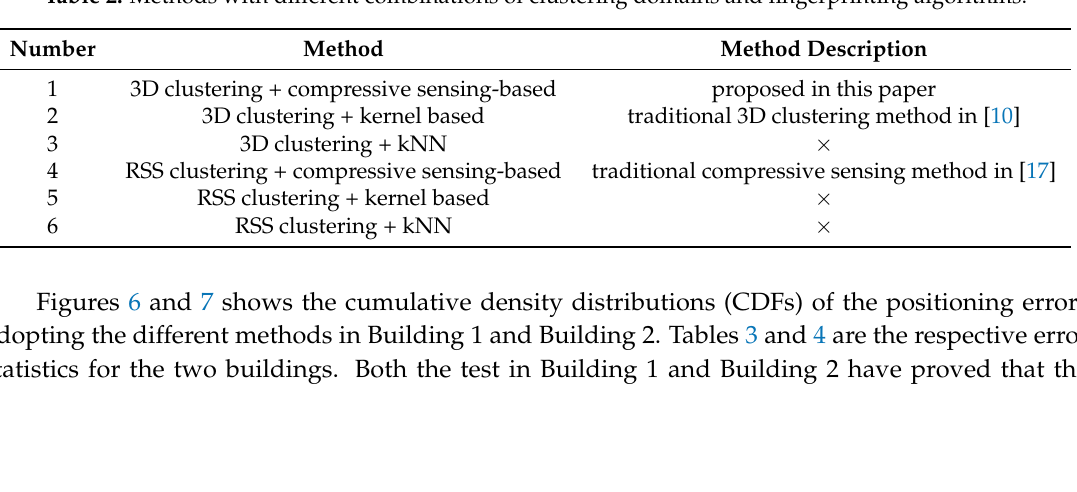
Table 2. Methods with different combinations of clustering domains and fingerprinting